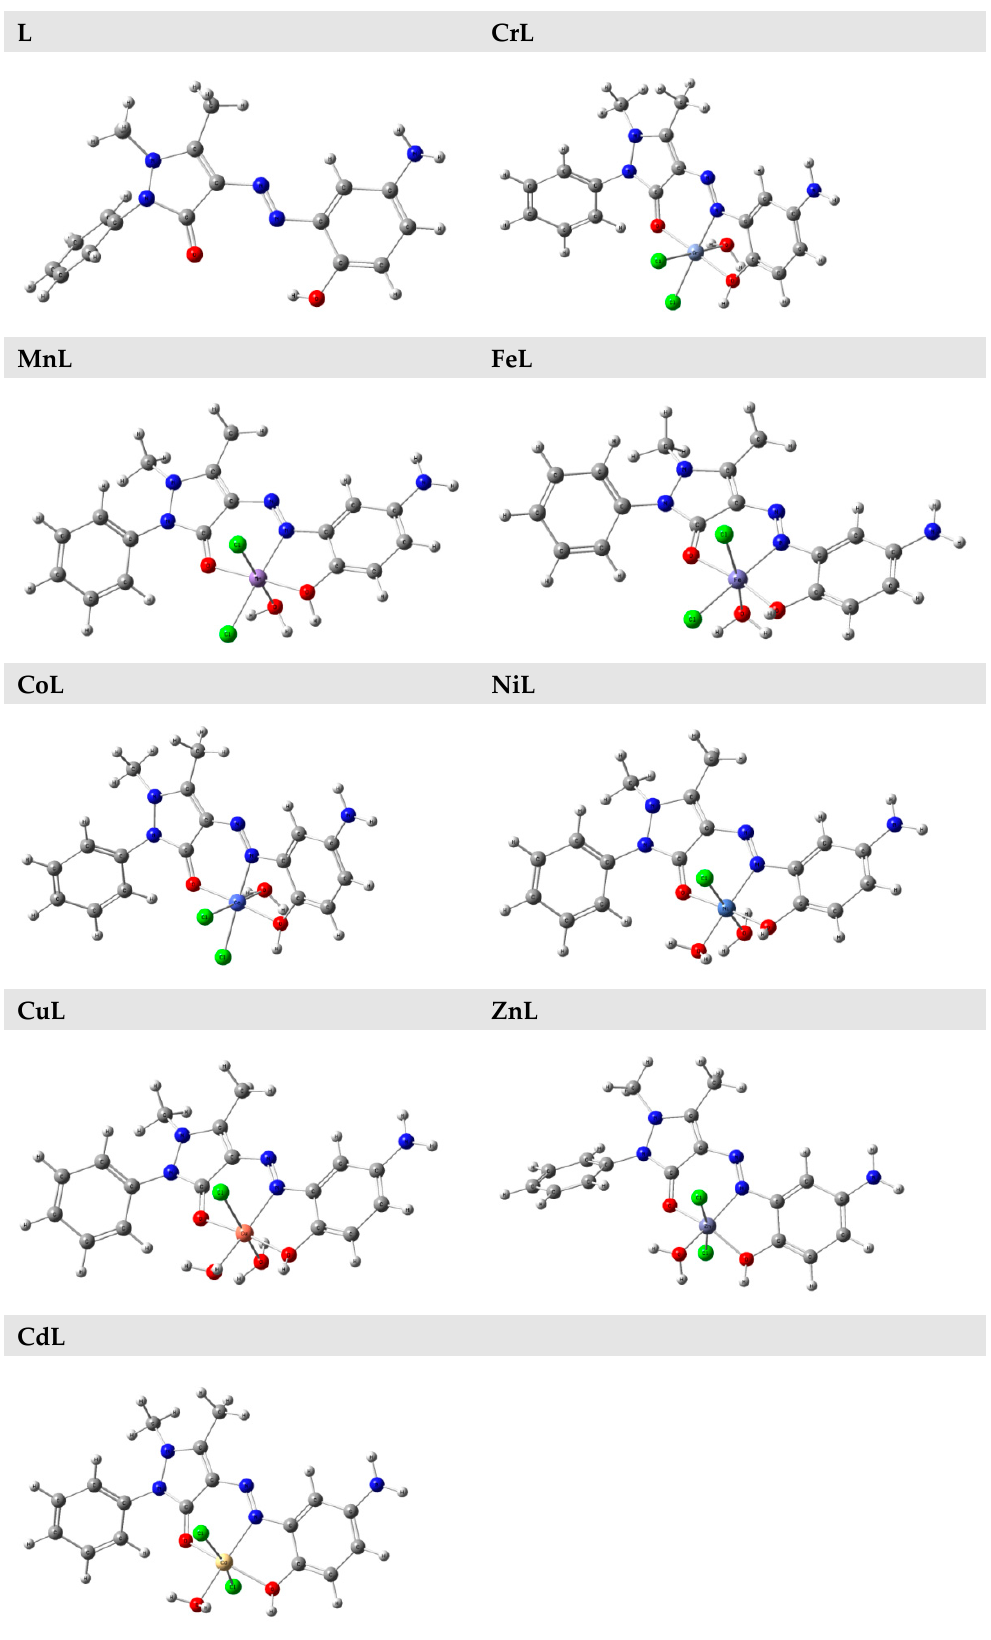
Figure 4. Optimized geometry of the studied compounds.